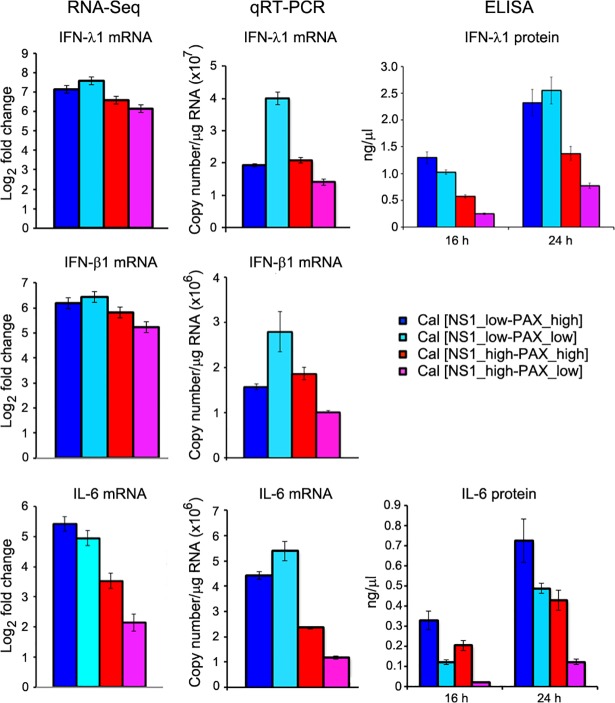
Validation of RNA-Seq data by qRT-PCR and ELISA.IFN-λ1, IFN-β1, and IL-6 mRNAs were quantitated by qRT-PCR and compared with RNA-Seq data. Secreted IFN-λ1 and IL-6 in the culture medium were quantified by ELISA at 16 and 24 h pi.